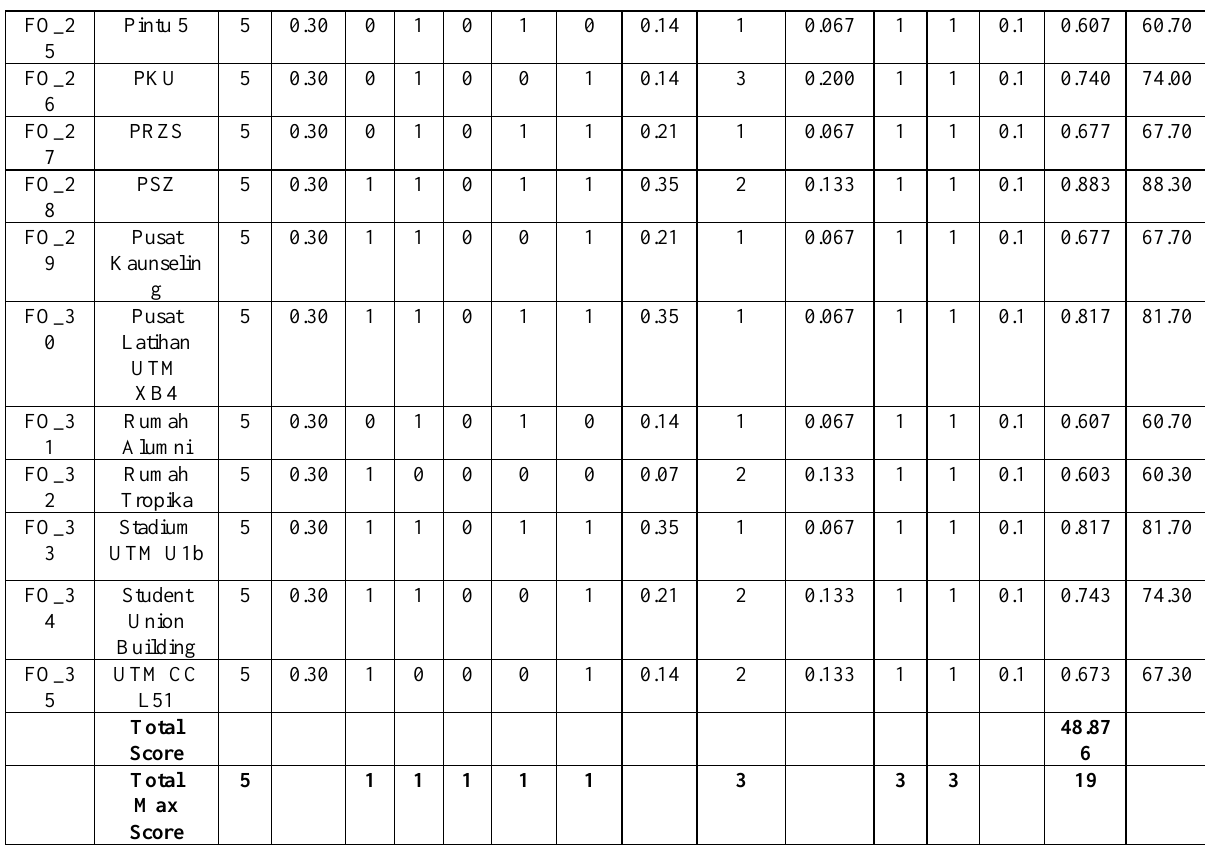
Table 7. Results of Safety Level Assessment analysis for Building in UTM Campus